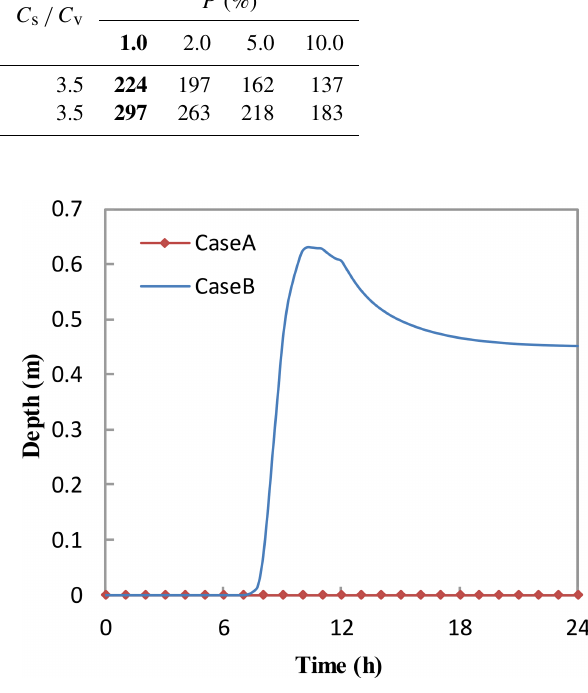
Figure 22. Comparison of water depth